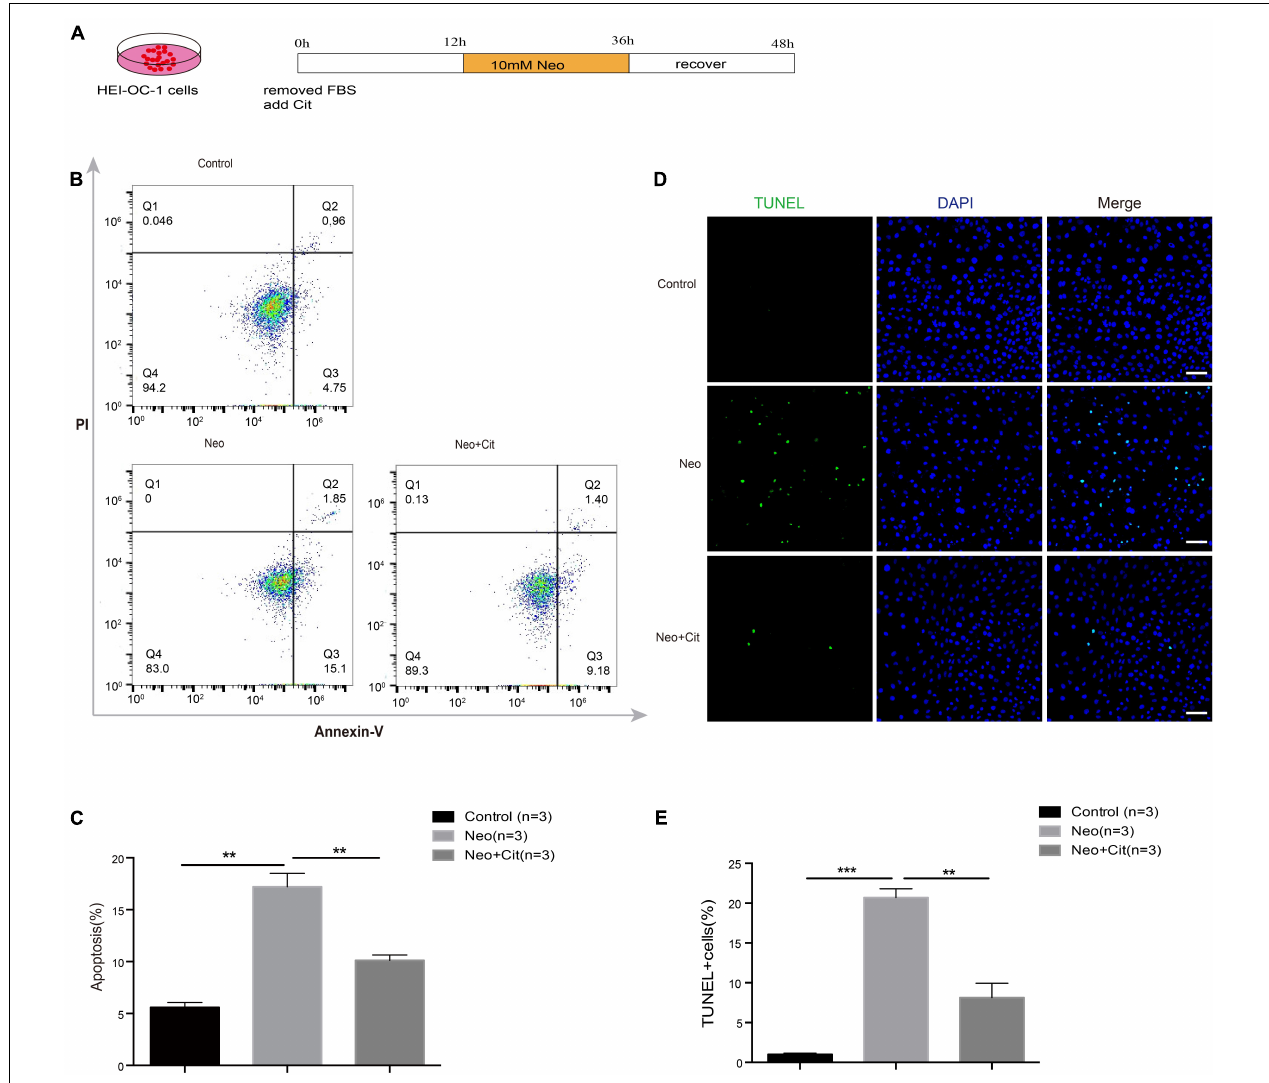
FIGURE 3 | Citicoline protects against apoptosis in HEI-OC-1 cells after neomycin exposure. (A) Schematic diagram of citicoline (Cit) and neomycin addition in cell culture. (B) Apoptosis analysis by flow cytometry after different treatments. The upper right quadrants, lower right quadrants, and lower left quadrants of the images represent late apoptotic cells, early apoptotic cells, and live cells, respectively. (C) Flow cytometry results showing that the percentages of apoptotic cells after neomycin treatment were significantly higher compared with the undamaged controls. The amount of apoptosis induced by neomycin was significantly reduced by pretreatment with citicoline. (D) TUNEL and DAPI double staining showing the apoptotic HEI-OC-1 cells after different treatments. (E) The number of TUNEL/DAPI double-positive cells after neomycin exposure was significantly reduced by treatment with citicoline. Data are shown as mean ± SD. * p < 0.05, ** p < 0.01, *** p < 0.001. Scale bars = 20 µ